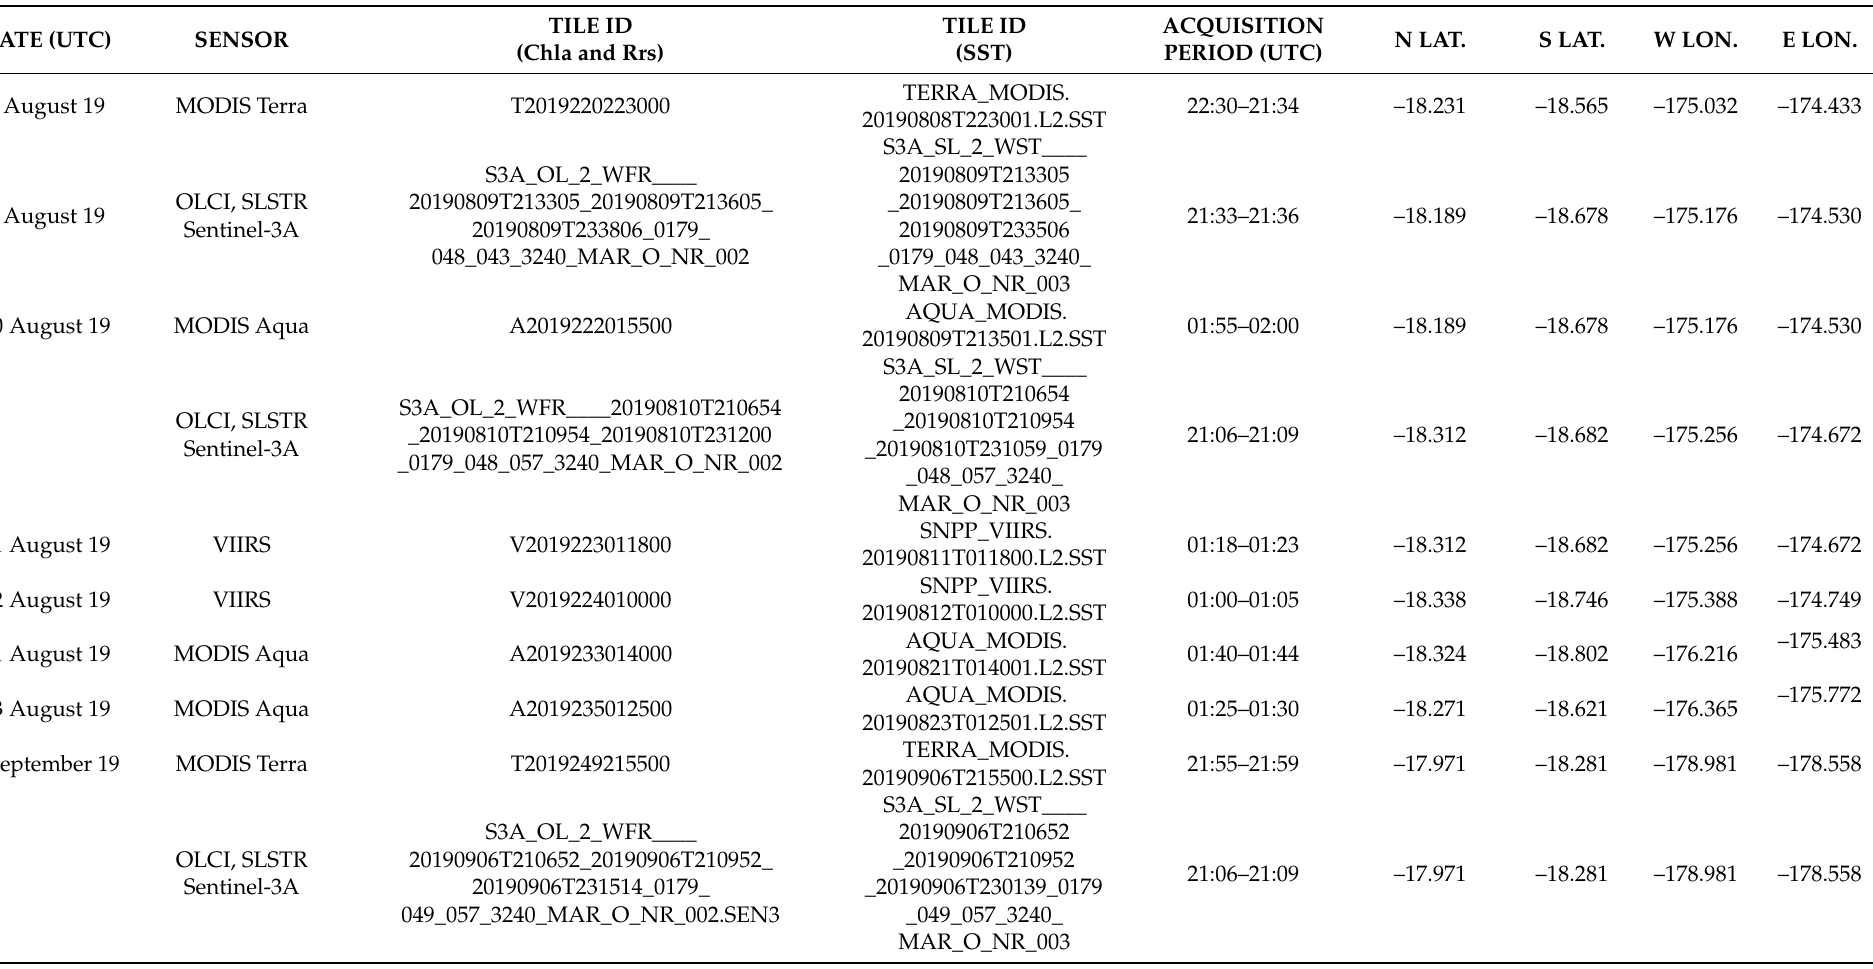
Table 1. Zoomed pumice area locations from OLCI, SLSTR, VIIRS, and MODIS-Aqua and -Terra sensors for observed dates in Coordinated Universal Time